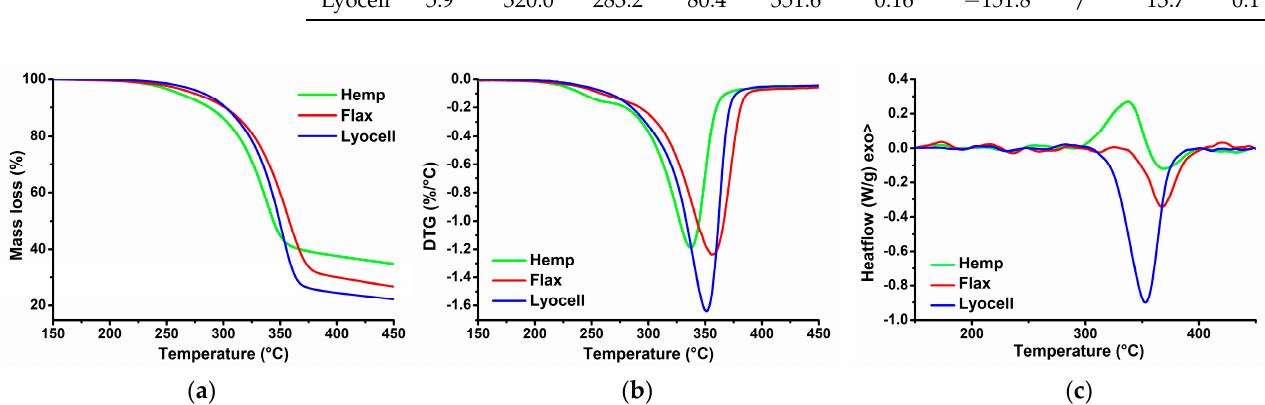
( b ) ( c ) Figure 2. Mass loss of fibres as a function of time during the isothermal TGA measurements at different temperatures: ( a ) hemp fibres; ( b ) flax fibres; ( c ) Lyocell fibres.